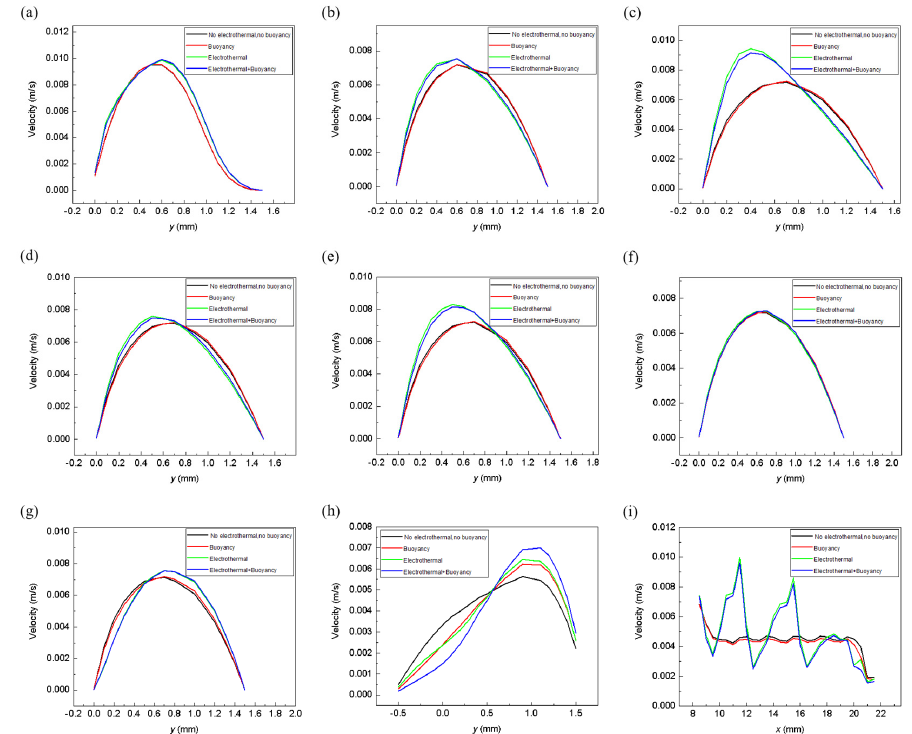
Figure A8. Influence of electrothermal and buoyancy forces on fluid flow in the separation channel: ( a ) x = 8.7 mm (electrode1: + U 0 ) ( b ) x = 10.05 mm (electrode2: floating) ( c ) x = 11.8 mm (electrode3: − U 0 ) ( d ) x = 13.8 mm (electrode4: floating) ( e ) x = 15.8 mm (electrode5: + U 0 ) ( f ) x = 17.8 mm (electrode6: floating) ( g ) x = 19.8 mm (electrode7: − U 0 ) ( h ) x = 20.5 mm ( i ) y = 0.2 mm.